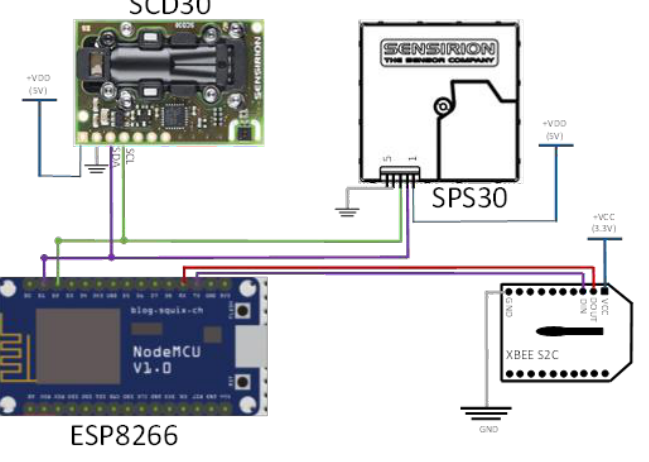
Figure 2. Sensor circuit node.